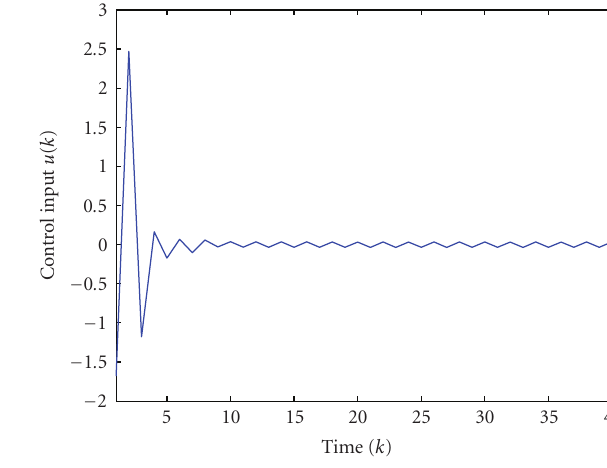
Figure 4: Control input u ( k